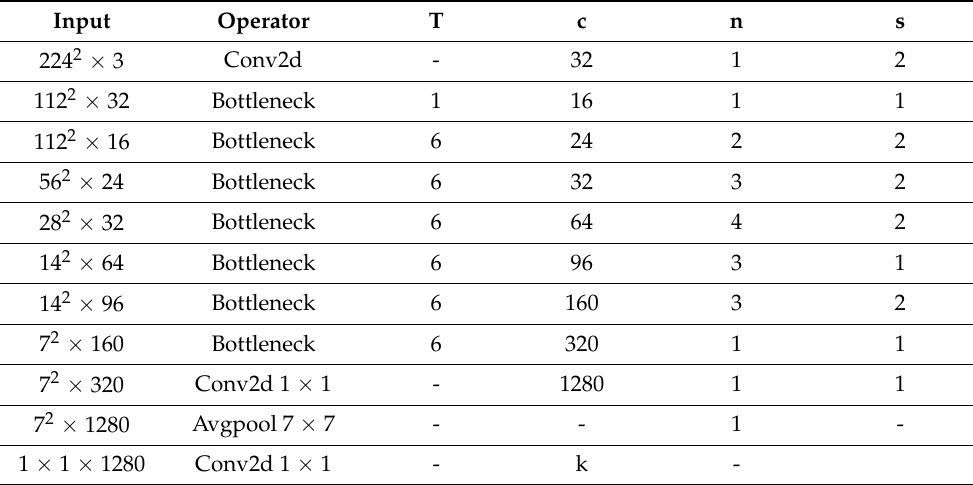
Figure 4. Network architectures for VGG16 and VGG19. Table 3. Network architectures for MobileNetV2